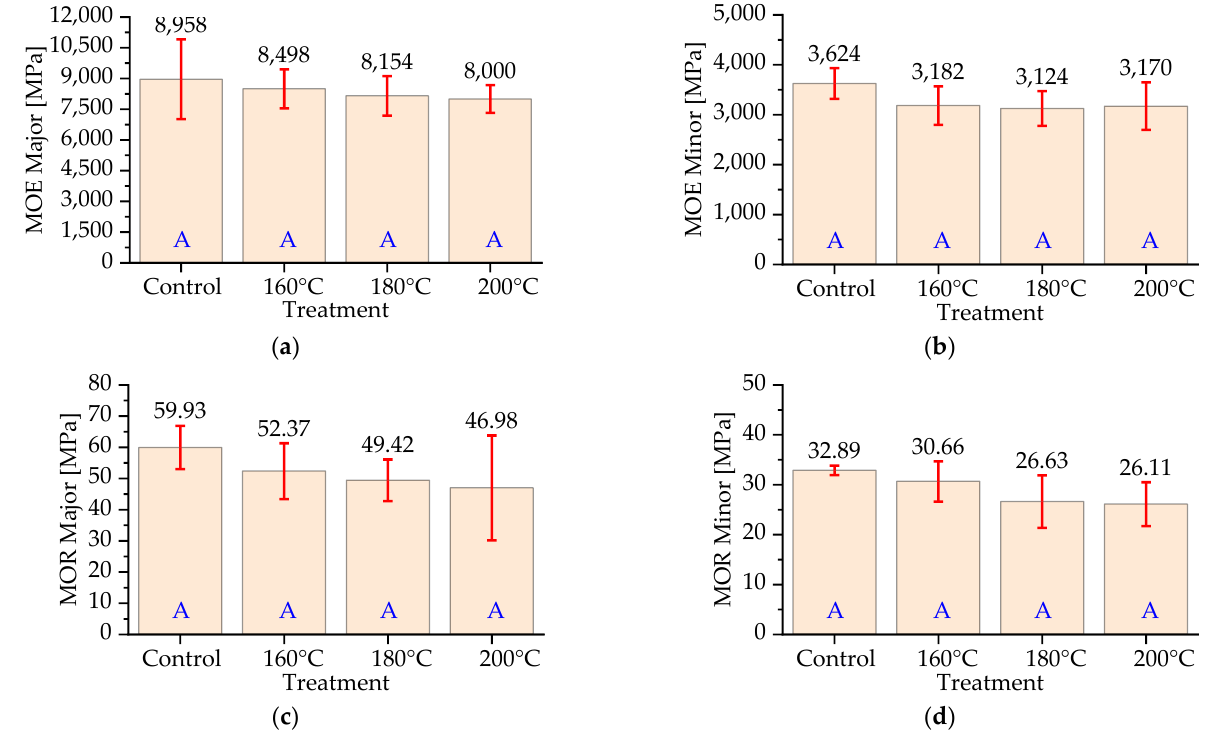
Figure 8. Mechanical properties of plywood produced with heat treated veneers: MOE major ( a ), MOE minor ( b ), MOR major ( c ) and MOR minor ( d ). Same letters in columns implies that there was no statistical difference with 95% of confidence.